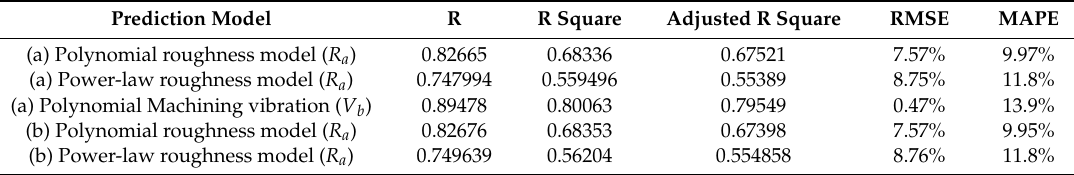
Table 2. Comparisons of statistical parameters of prediction